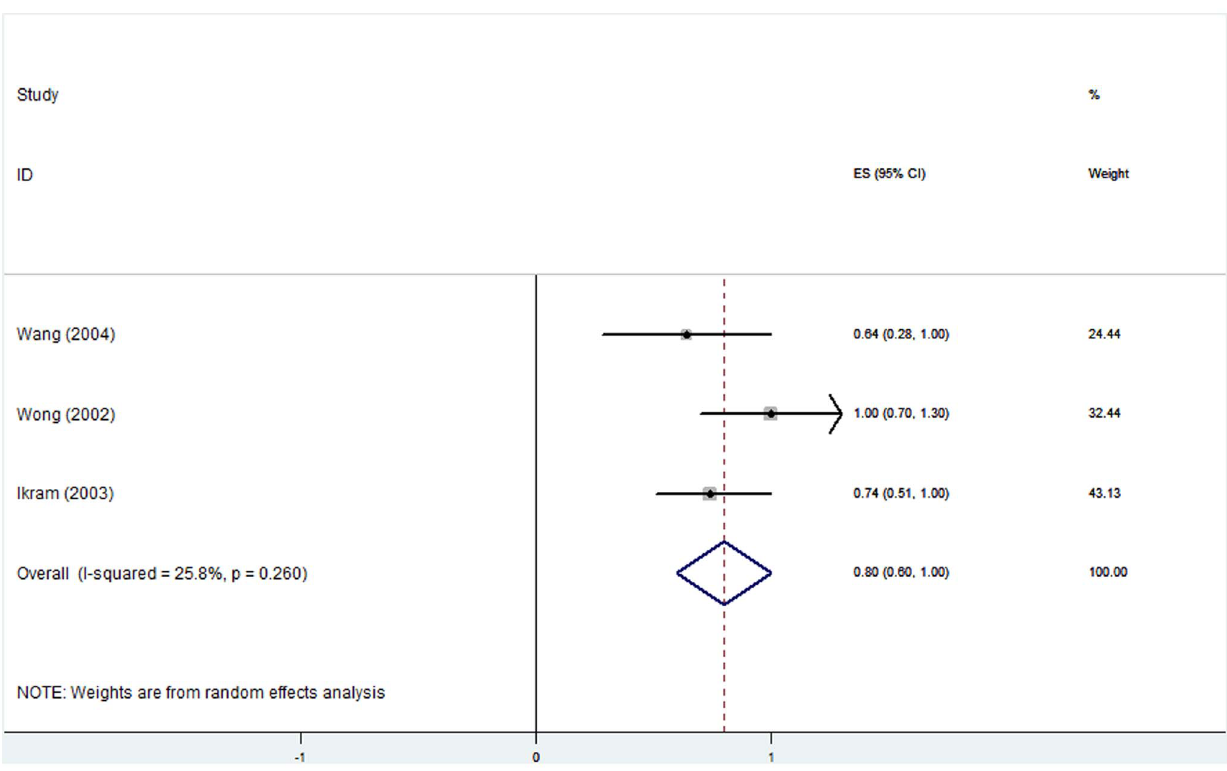
Figure 5. Myopia and early AMD incidence: forest plot of pooled odds ratios for a random-effects meta-analysis of early AMD incidence and myopia. CI, confidence interval.